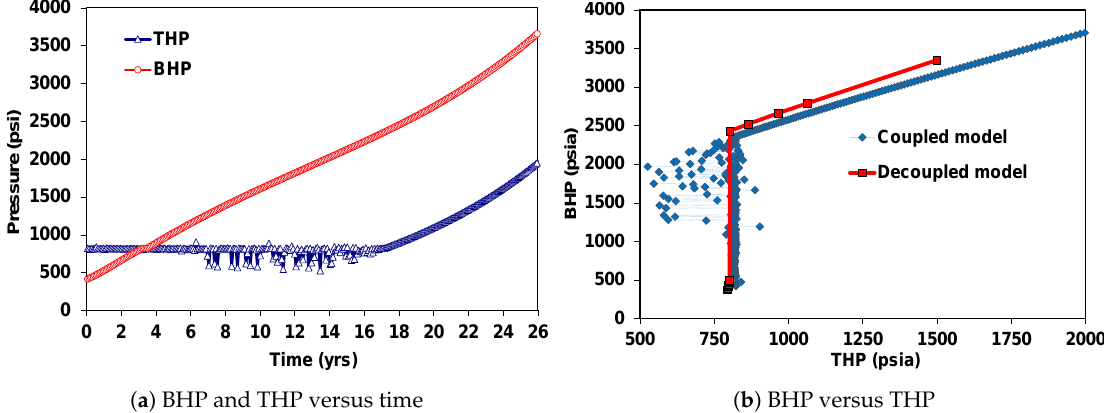
Figure 15. BHP and THP versus time from the coupled model ( a ) and comparison of the BHP–THP curves from the coupled and decoupled models ( b